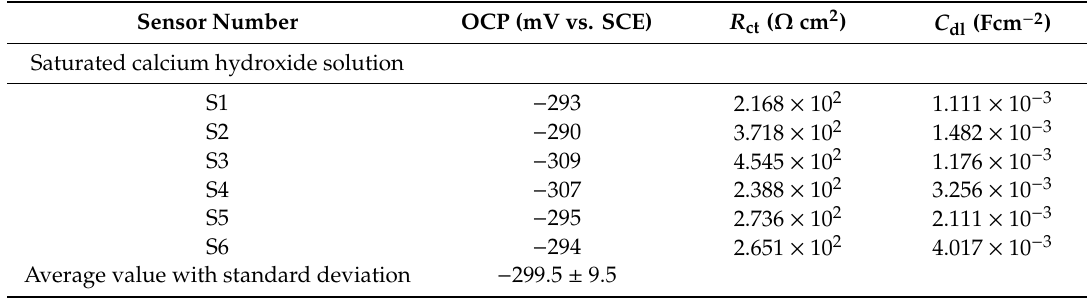
Table 5. Impedance parameters for six di ff erent sensors (S1 to S6) with NiFe 2 O 4 reference sensor in concrete environments. Reproduced with permission from ref. [97]. Copyright 2010 Elsevier.